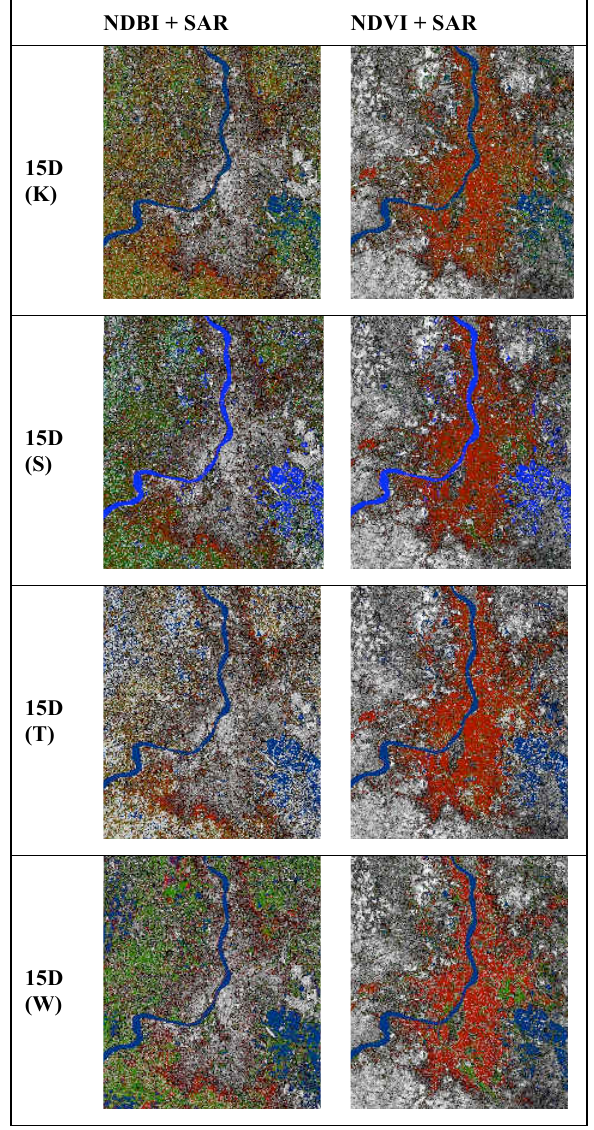
Figure 4: Combination of NDBI and NDVI with Sentinel-1 data classified images; 15D: 15 th December; (K): K-Means clustering; (S): Supervised classification; (T): Texture image; (W): Wishart H-A-Alpha